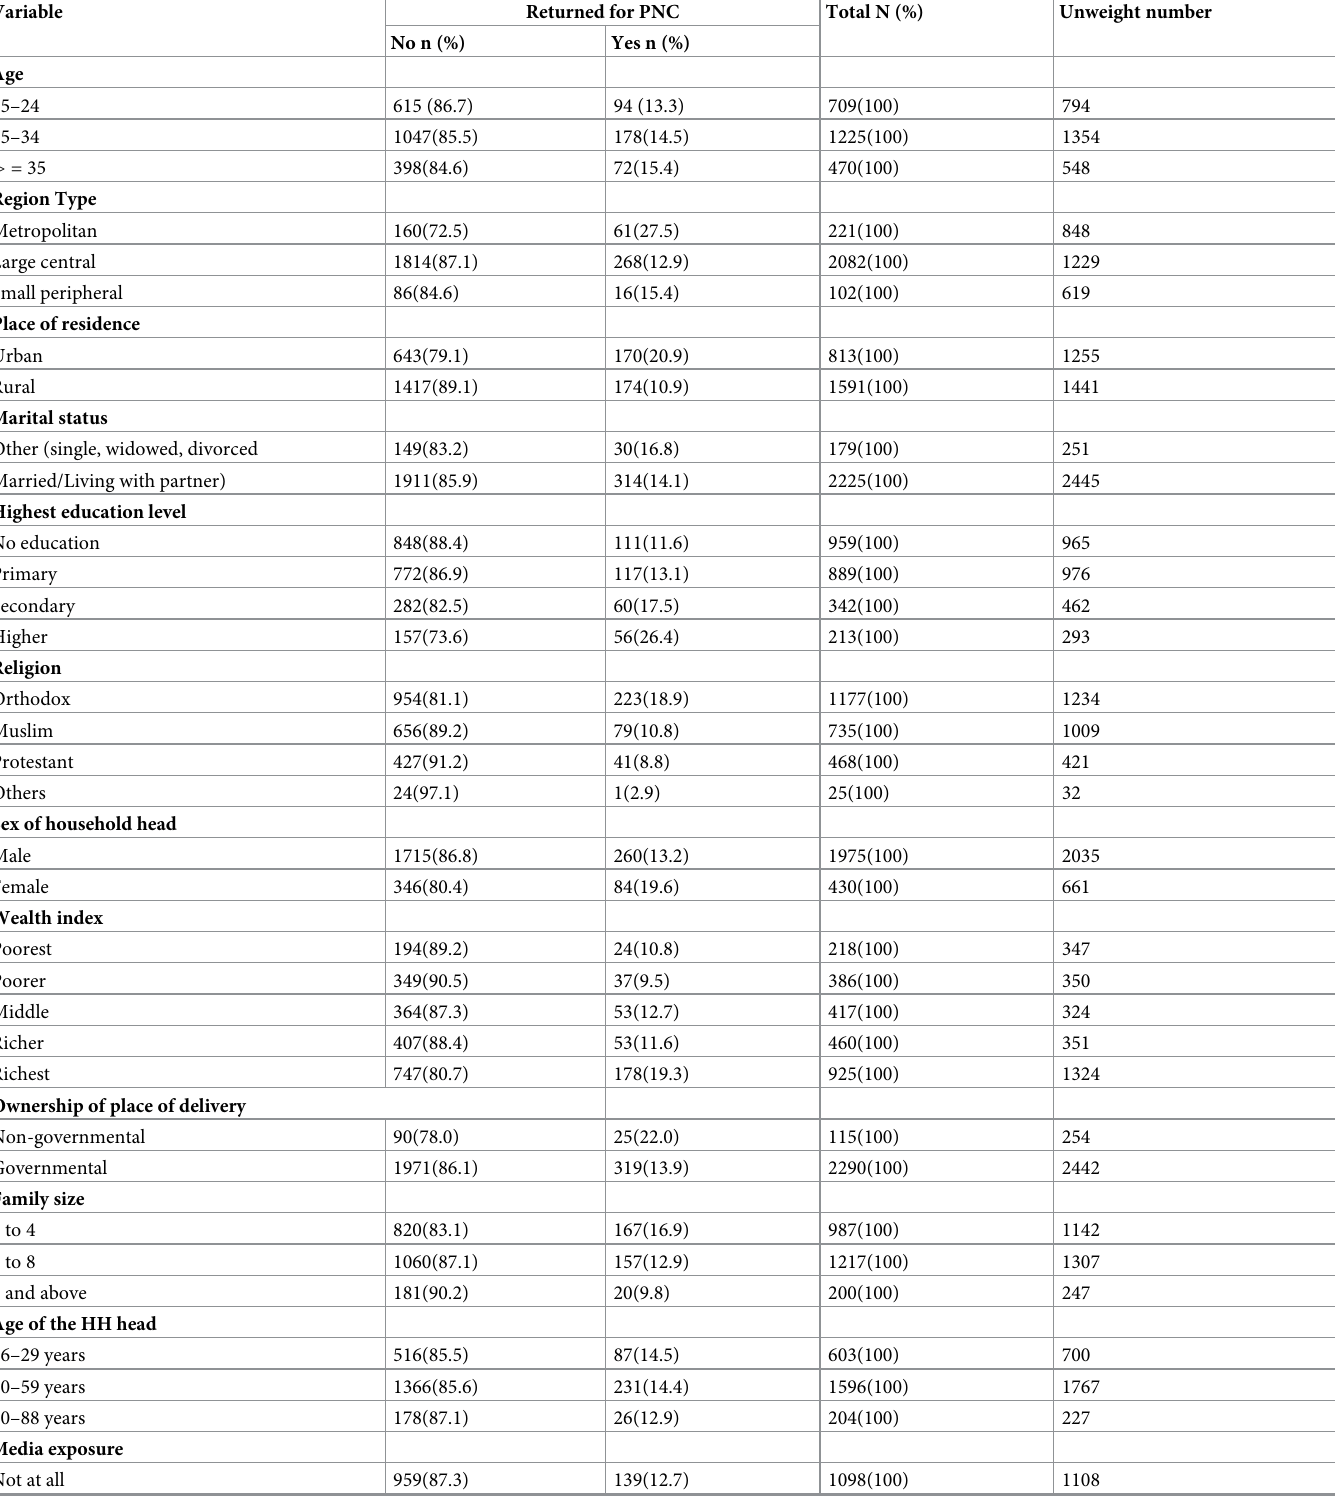
Table 1. Socio-demographic and socio-economic characteristics of study participants, analysis from the 2016 EDHS, (N =